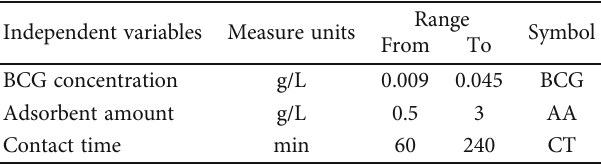
Figure 2: SEM images of the commercial AC: pore size, shape, and alignment. Table 2: Designated variables and their variation range for BCG decolorization with active